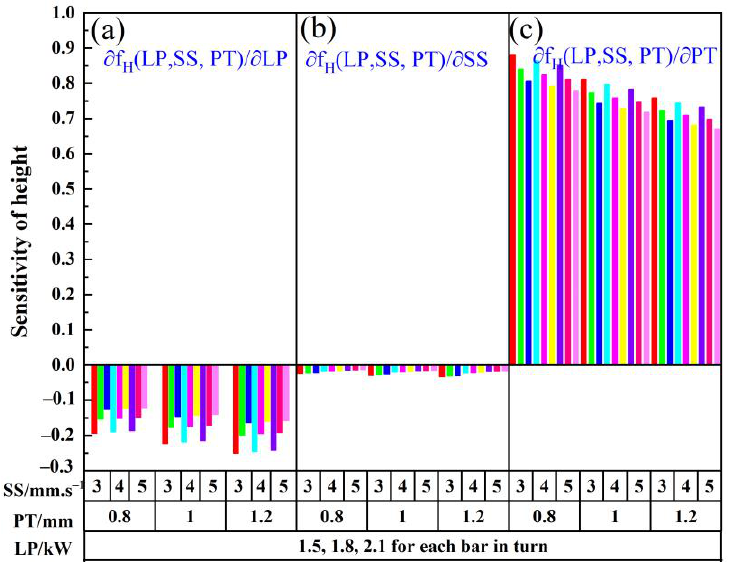
Figure 6. Sensitivity of height to cladding parameters. ( a ) laser power; ( b ) scanning speed; ( c ) powder thickness.